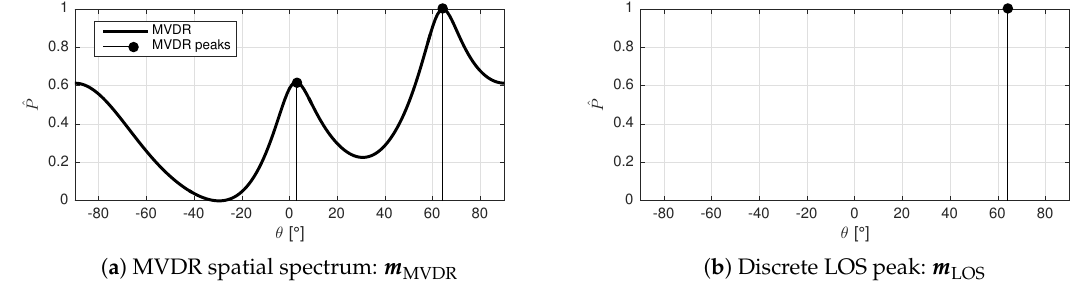
Figure 3. Example measurement